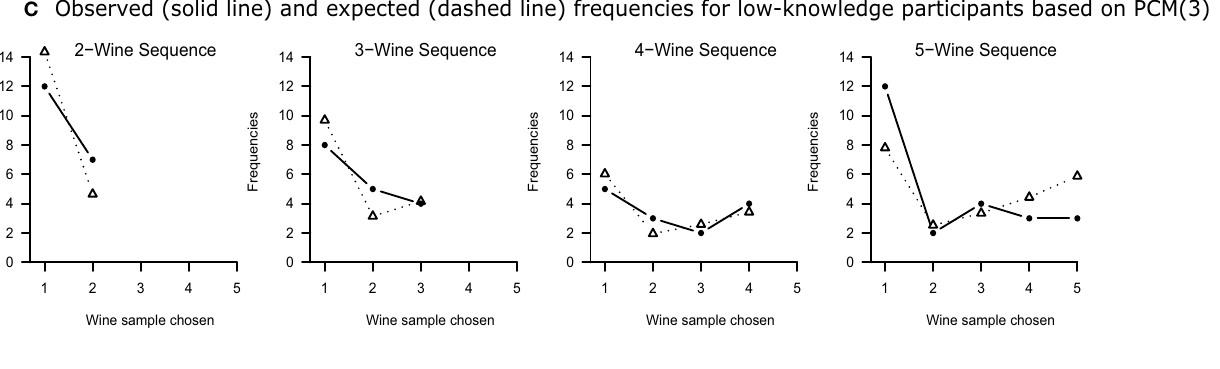
Observed (solid lines) and expected frequencies (dashed lines) for the 1-parameter PCM(3) model applied to the choice frequencies of Mantonakis et al.’s (2009) high vs. low knowledge participants,